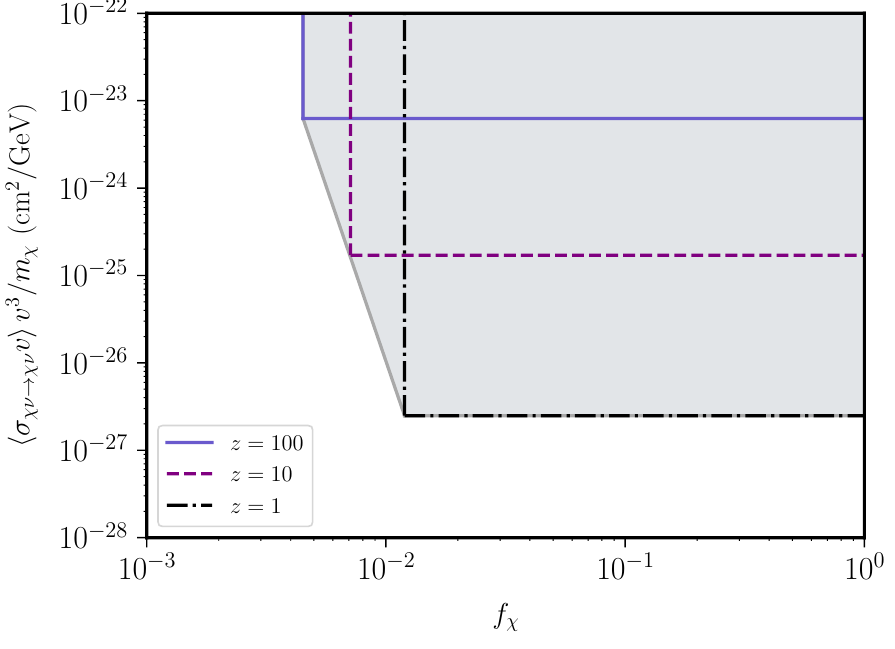
Figure 3 . Excluded region (95%), in grey, in terms of the fraction of matter interacting with neutrinos, f χ , and the scattering cross section, as determined by h σ χν → χν v i v 3 /m χ , in cm 2 /GeV. The grey region combines constraints on the power spectrum from efficient momentum exchanging starting at any redshift from z = 100 to 1 . In addition, we show the fixed- z exclusions for cross- sections producing efficient momentum exchange at redshifts z = 100, 10 and 1 in blue (solid), purple (dashed) and black (dashed-dot) respectively. We see that low redshifts have more constraining power at larger f χ , as anticipated by the enhancement in equation (2.12). We also see that the excluded range of f χ decreases with decreasing cross-section. Smaller cross-sections only produce efficient scattering at lower redshifts, reducing the size of the log in equation (3.15) and therefore the amplitude of the suppression.